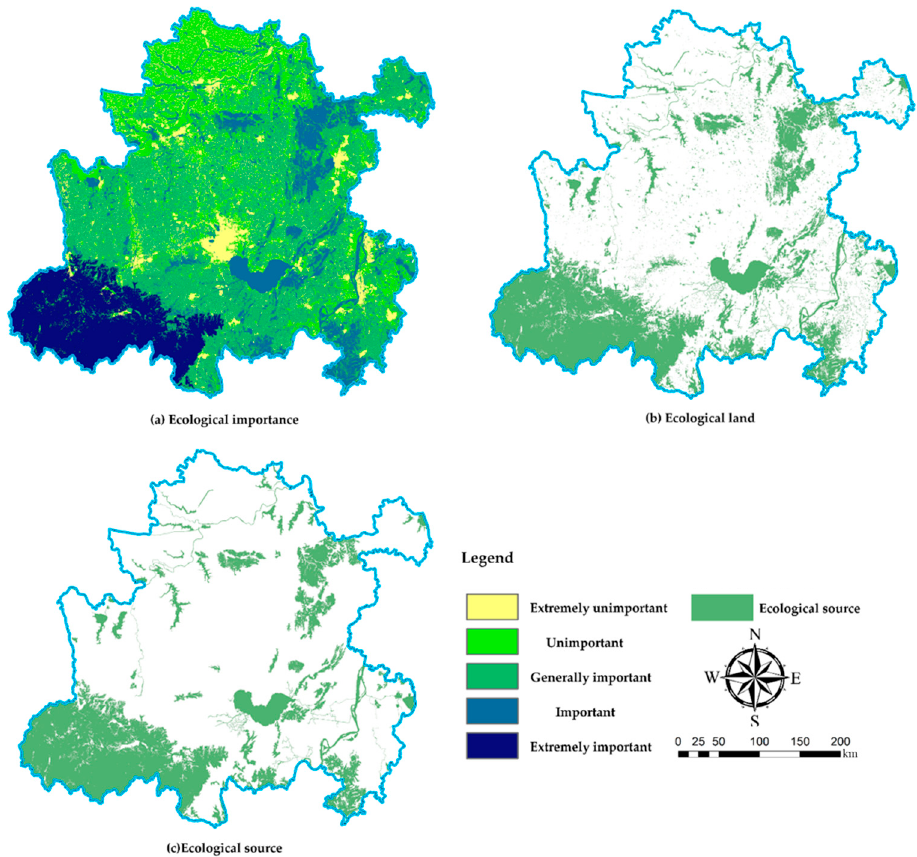
Figure 5. Results of ecological source identification of Hefei metropolitan